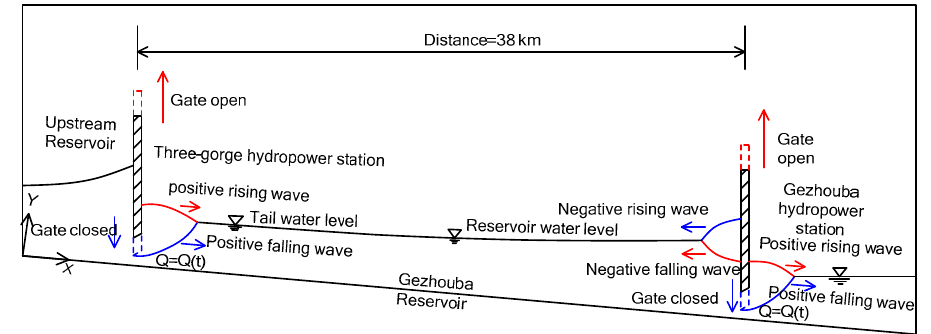
Figure 12. Schematic diagram of the Three Gorges and Gezhouba cascade hydropower station.